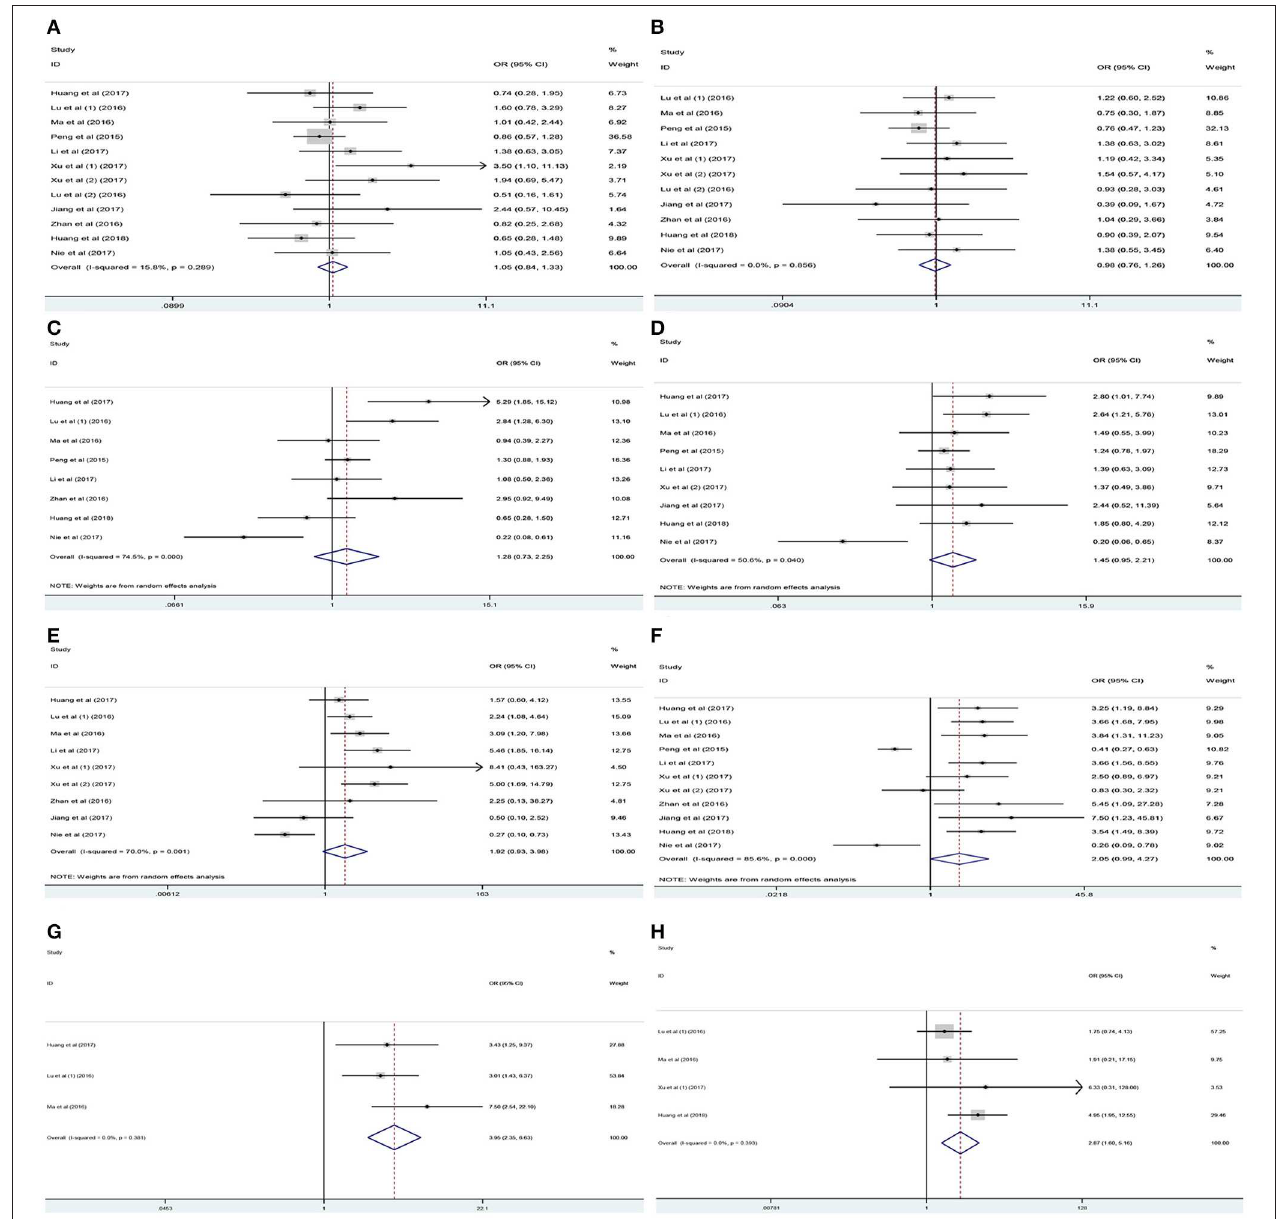
FIGURE 6 | Association between PANDAR expression levels with clinicopathological characteristics of cancer patients. (A) Age, (B) gender, (C) tumor size, (D) differentiation grade, (E) lymph node metastasis, (F) tumor stage, (G) depth of invasion, (H) distant